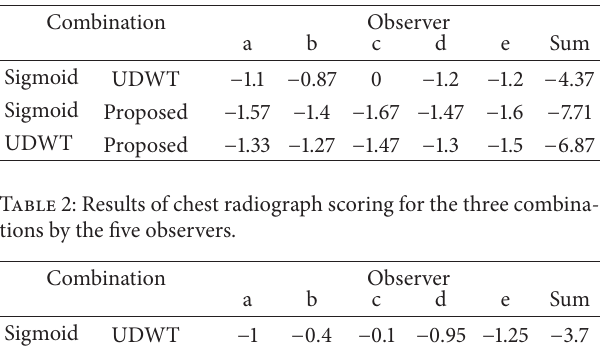
Table 1: Results of mammogram scoring for the three combinations by the five observers.